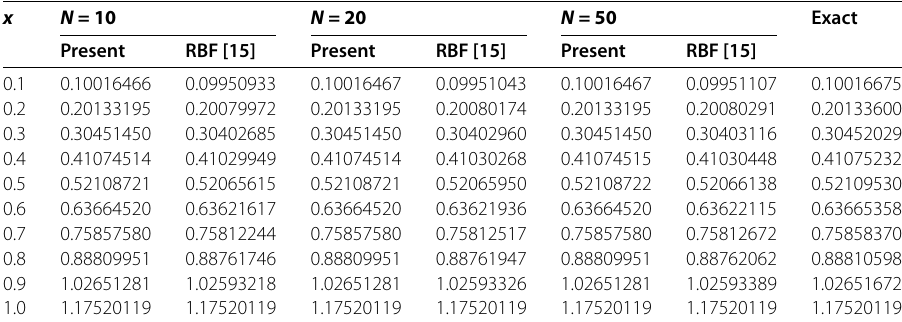
Table 7 The comparison of results for Example 3 when N = 50 and γ = 1.5 at t = 1